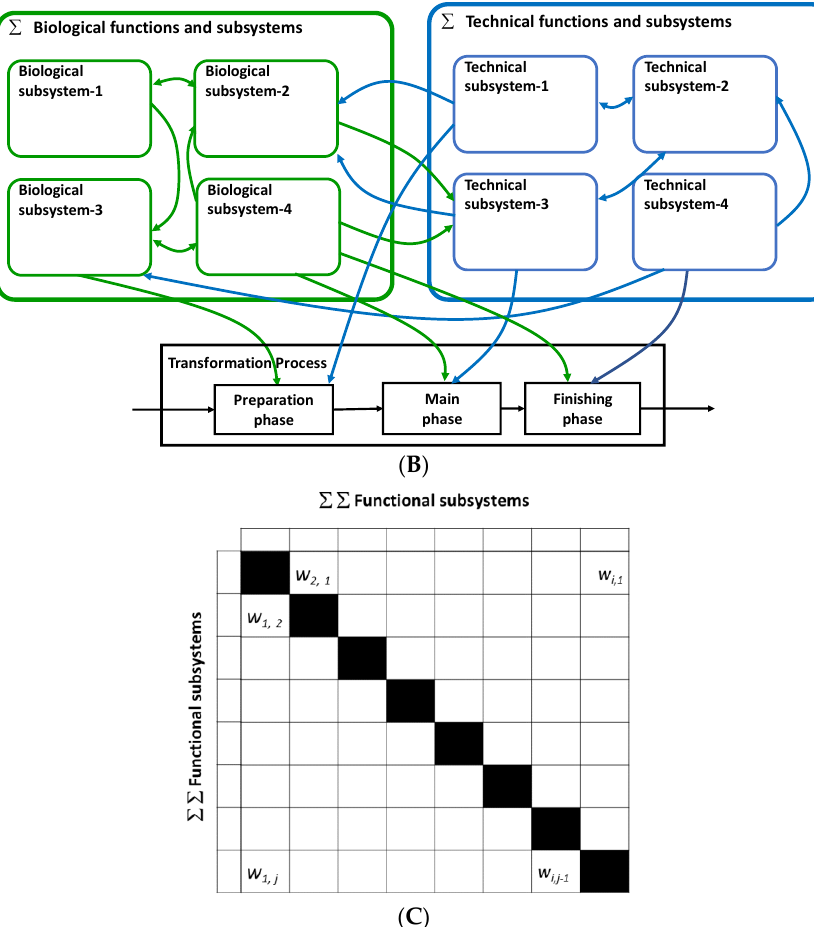
Figure 3. ( A ) Overall Hubka-Eder map showing the transformation process and functional systems; ( B ) a zoom-in of the biological and technical subsystems and their interactions in between and with the transformation process phases; and ( C ) the interaction matrix with assessed interaction effects between subsystems.